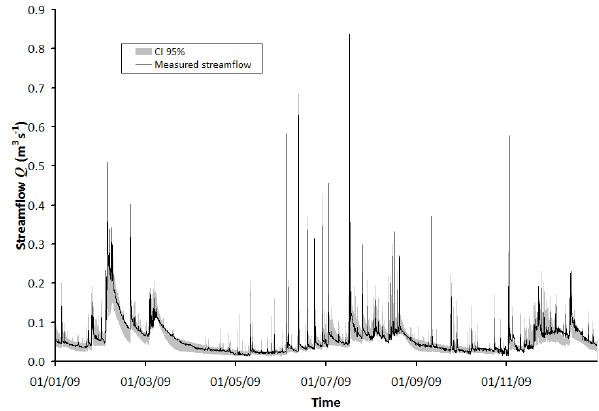
Fig. 9. Measured streamflow against empirical 95% confidence in-